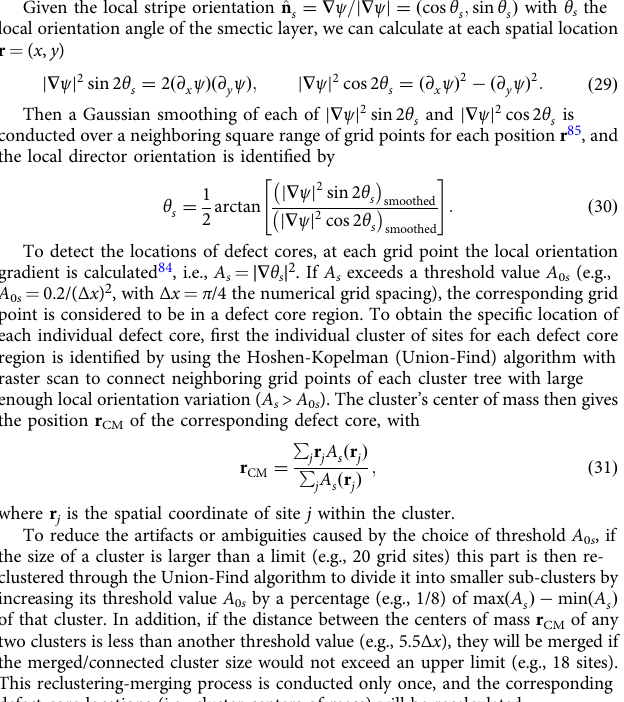
algorithm based on the combination of two methods given in Refs. 84,85 , with some modi fi cations and extension. The implementation steps are described